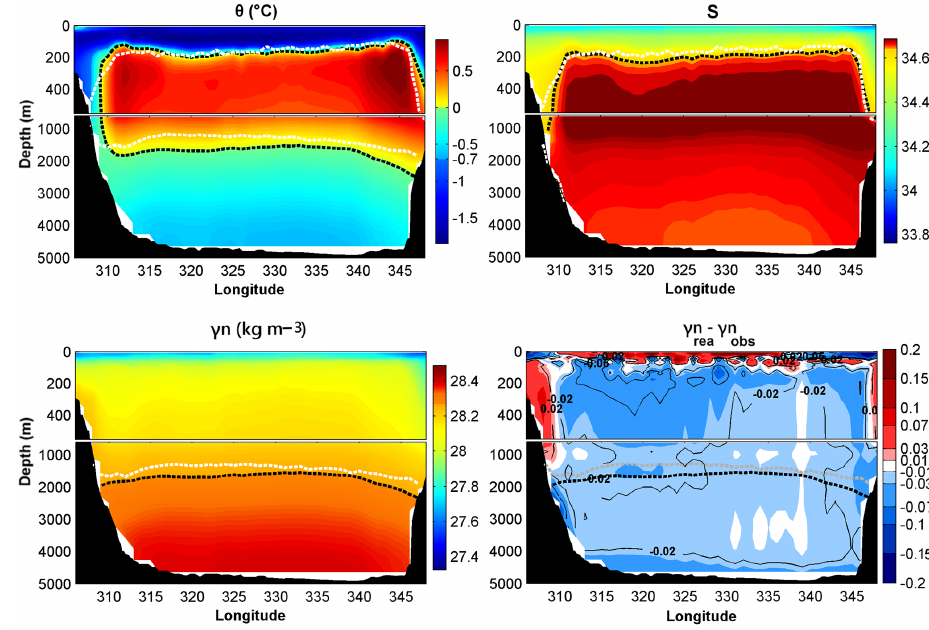
Figure 10. Same as in Fig. 9, except for section WOCE